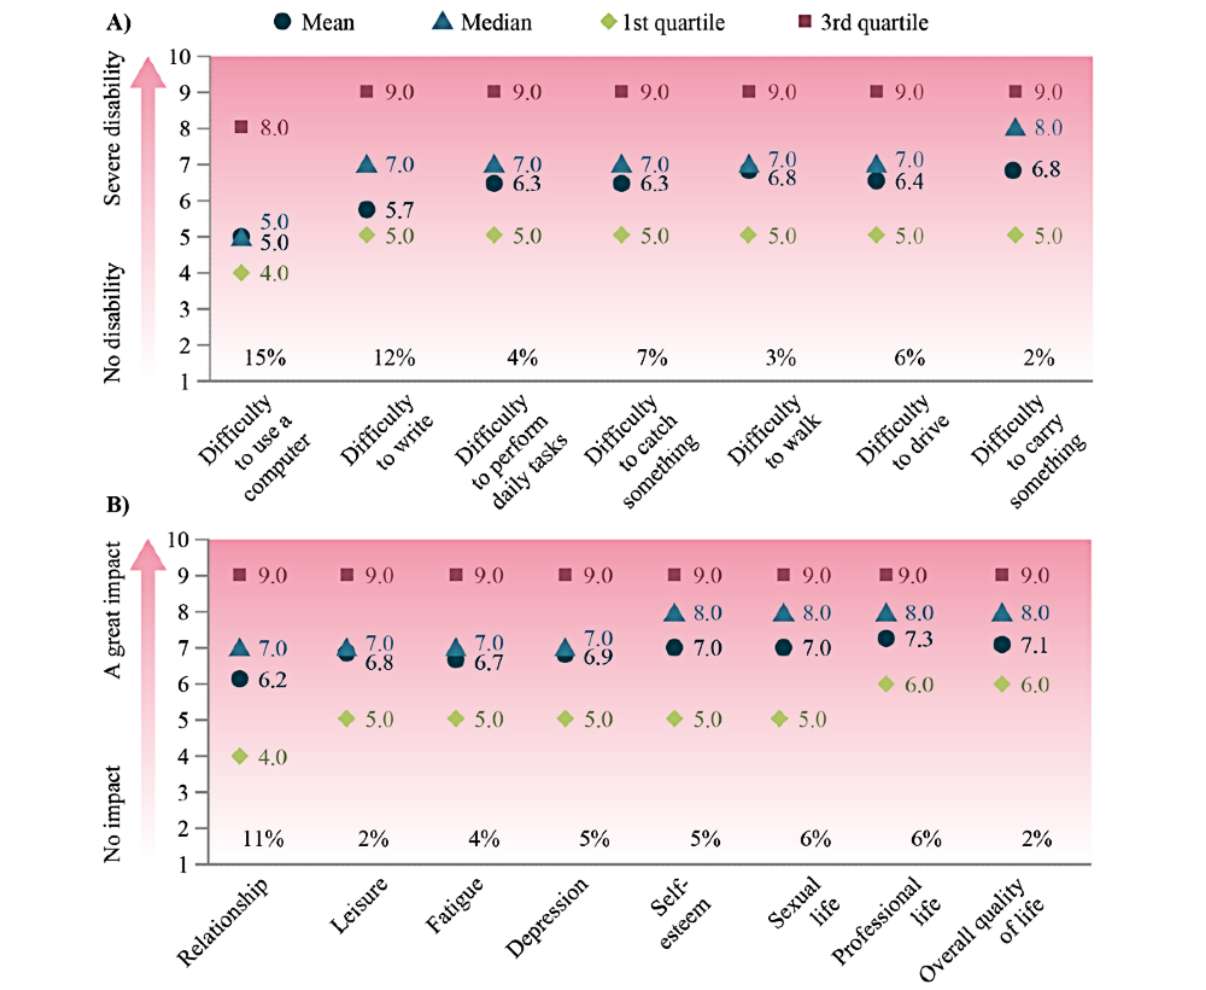
Figure 2. Patient responses on the impact of spasticity on the patients’ (A) ability to perform everyday tasks (“For each of the following items, please assess the level of difficulty you experience due to your spasticity,” on a scale of 0=no disability to 10=severe disability) and (B) quality of life (“Please assess to what extent spasticity affects your life,” on a scale of 0=no impact to 10=a great impact; n=427).